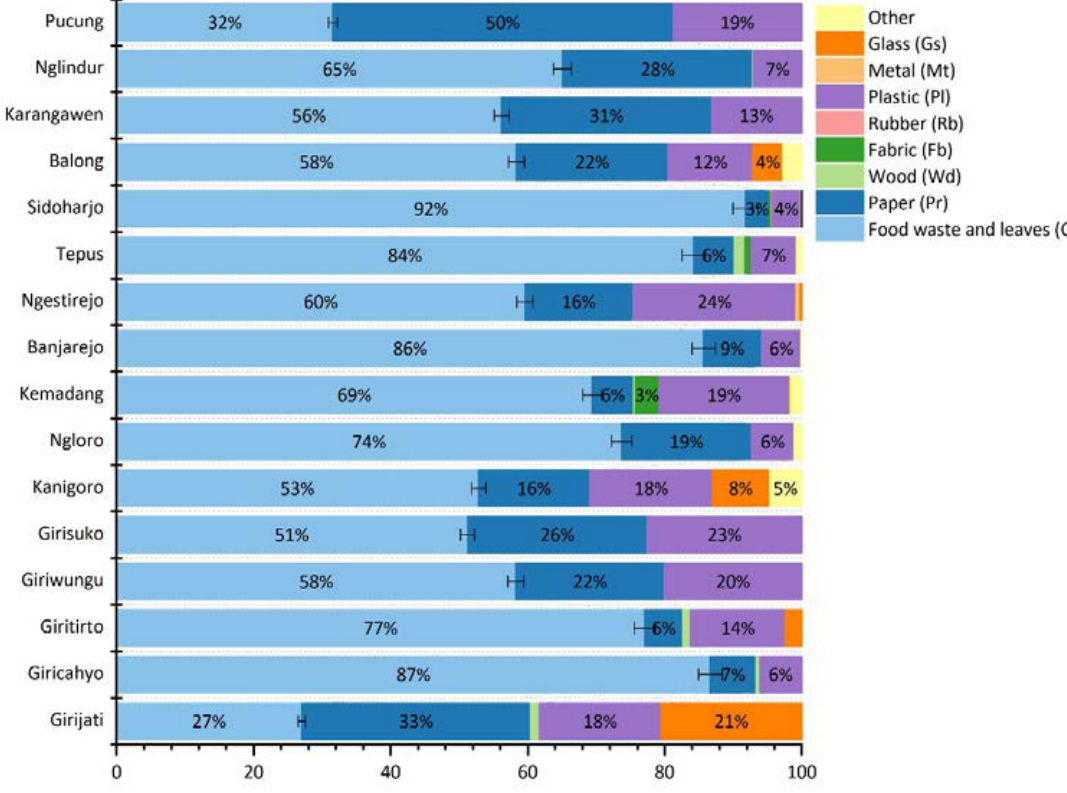
Fig. 4: Waste composition based on sample villages